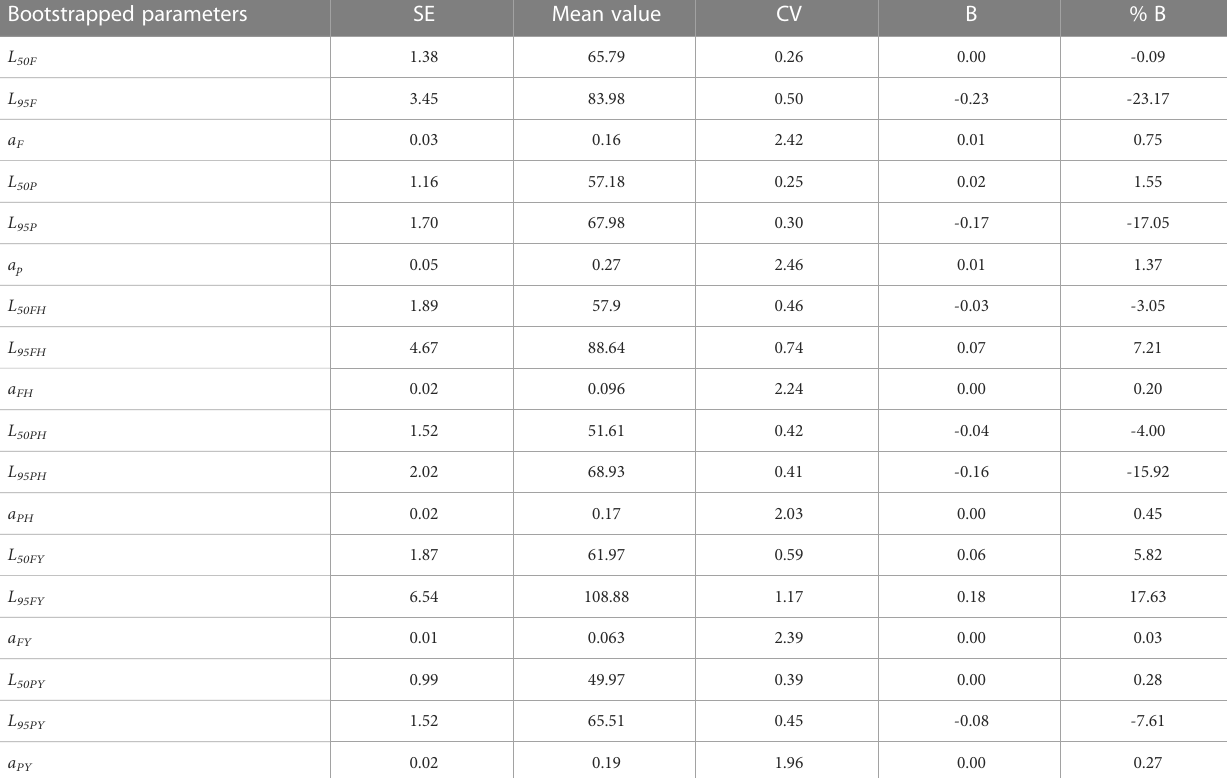
The L 50 isthelengthat50%maturityparameterandawhichdescribesthelengthoftheintervalofthemodelarethemodelparametersforeachlogisticcurve.The L 95 ,thelengthat95%maturity, was derived from the ouput of the model. Each of the six maturity classi fi cation criteria are described by their subscript: Functional maturity during the spawning period (F), Physiological maturity during the spawning period (P), Functional maturity hybrid during the spawning period (FH), Physiological maturity hybrid during the spawning period (PH), Functional maturity during all monthsofthe year collected(FY), Physiological maturity during all monthsof theyear collected(PY). Standard error (SE), meanvalue(stated incm FL),coef fi cient ofvariation (CV), bias (B), and the percent bias